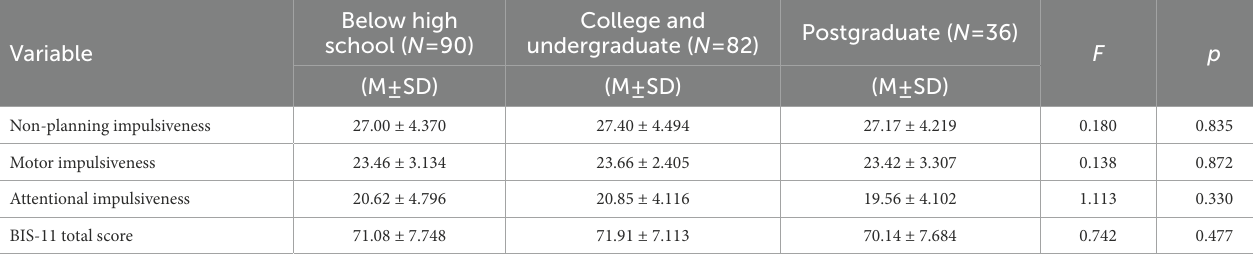
TABLE 3 Educational background difference test of trait